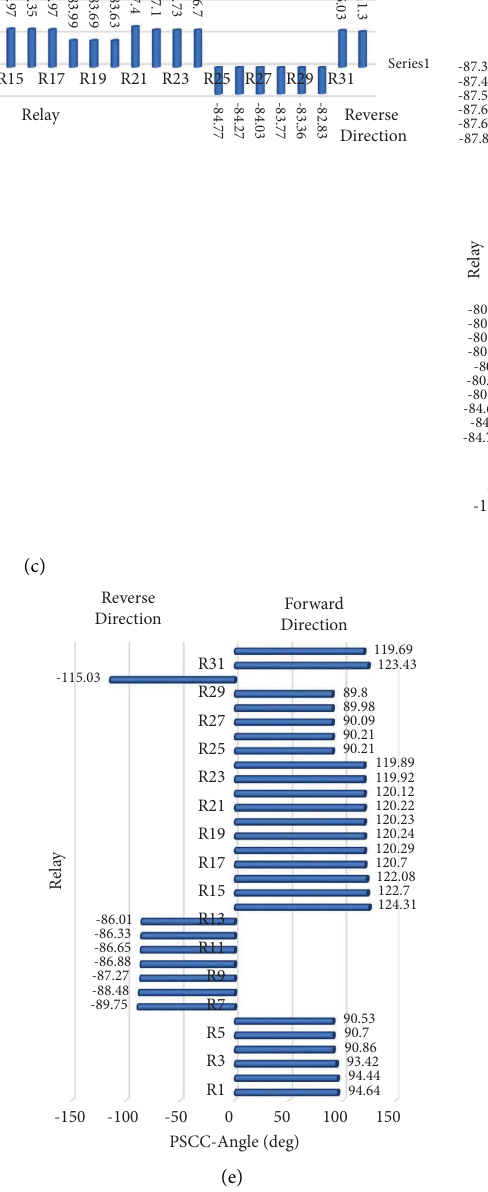
Figure 14: PSCC angle values and their sing at all relays for (a) LG fault at S8, (b) LG fault at S16, (c) LLG fault at S20, (d) LLLG fault at S24, and (e) LL fault at